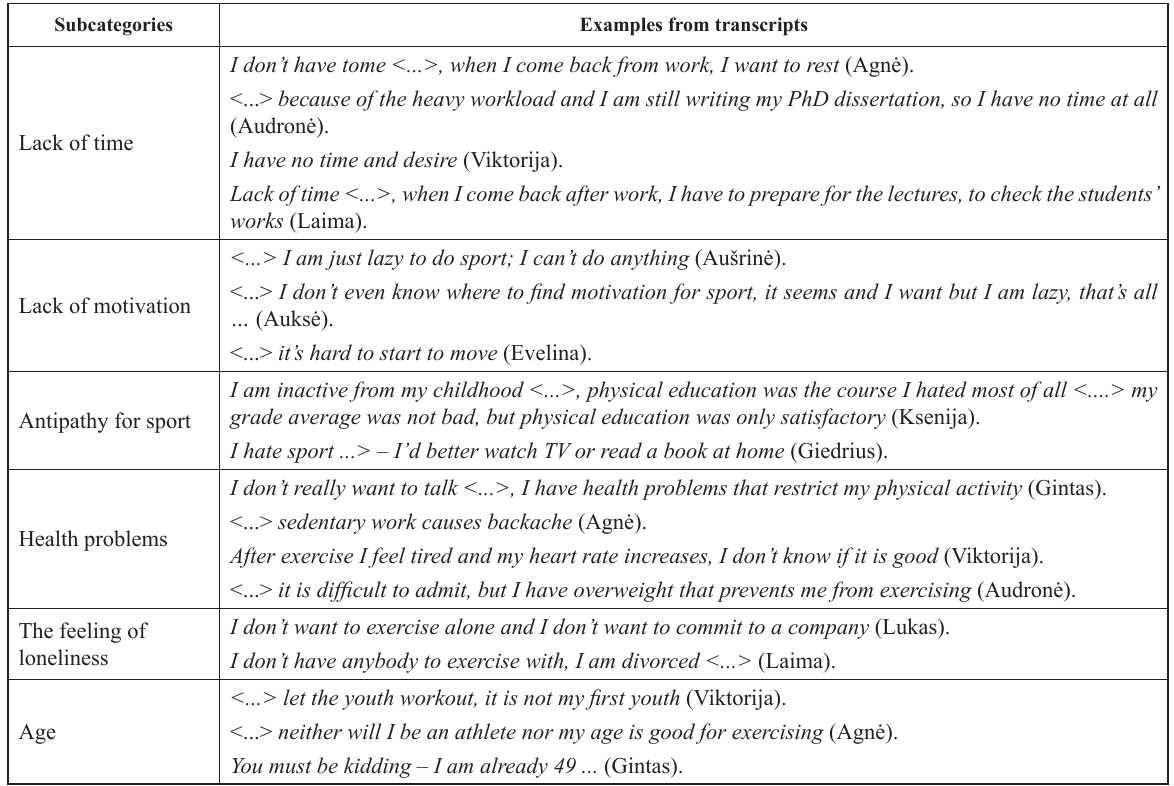
Table 6. Internal causes of physical inactivity Subcategories Examples from